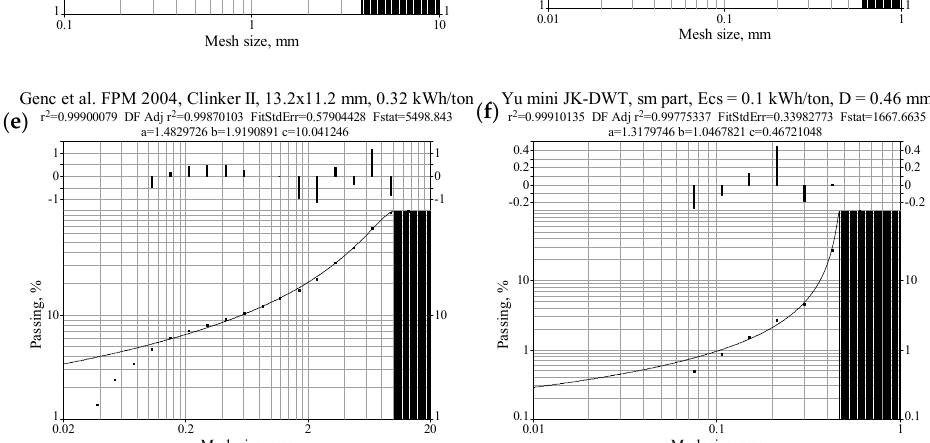
Figure 7. Swebrec fits. ( a ) Large particles, high fidelity over whole size range. ( b ) Medium sized particles, medium fidelity over whole range. ( c ) Small particles with lower fidelity, note RR-like curve form. ( d ) Very small particles with high energy input, high fidelity but datum for x < 0.1 mm excluded. ( e ) Medium sized particles, excluding rapidly decreasing mass passing values in fines range x < 0.1 mm, otherwise high fidelity. ( f ) Same as (e) but very small particles. Grey area on the right of the graphs is where x > x max , hence the fit does not apply there. Vertical bars on top are residuals. Relating to Equation (1), the parameters in the heading convert as follows: a → b , b → x max / x 50 , c → x max